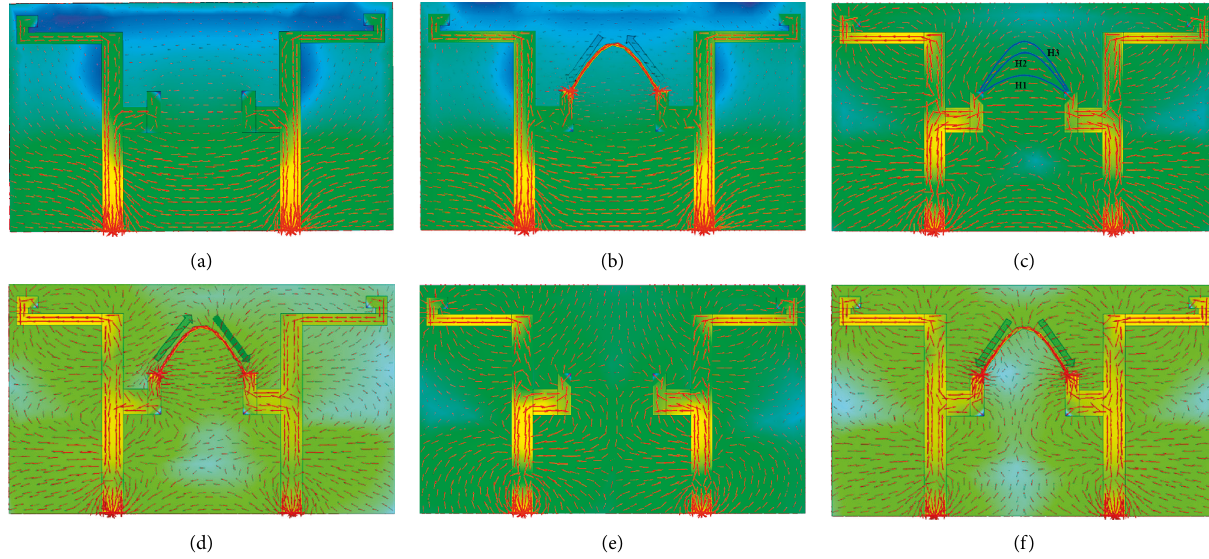
Figure 4: Characteristic current distribution of the significant modes of antenna#1: (a) mode 1 at 2.45GHz, (b) mode 1 at 2.45 GHz,